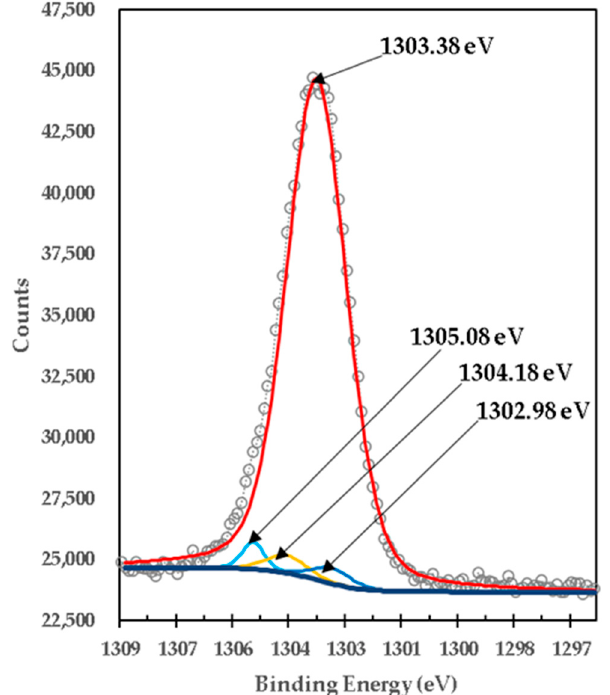
Figure 10. XPS high-resolution spectra of Mg1s in titania mixed with brucite and calcined at 1100 °C for 1 h M1.